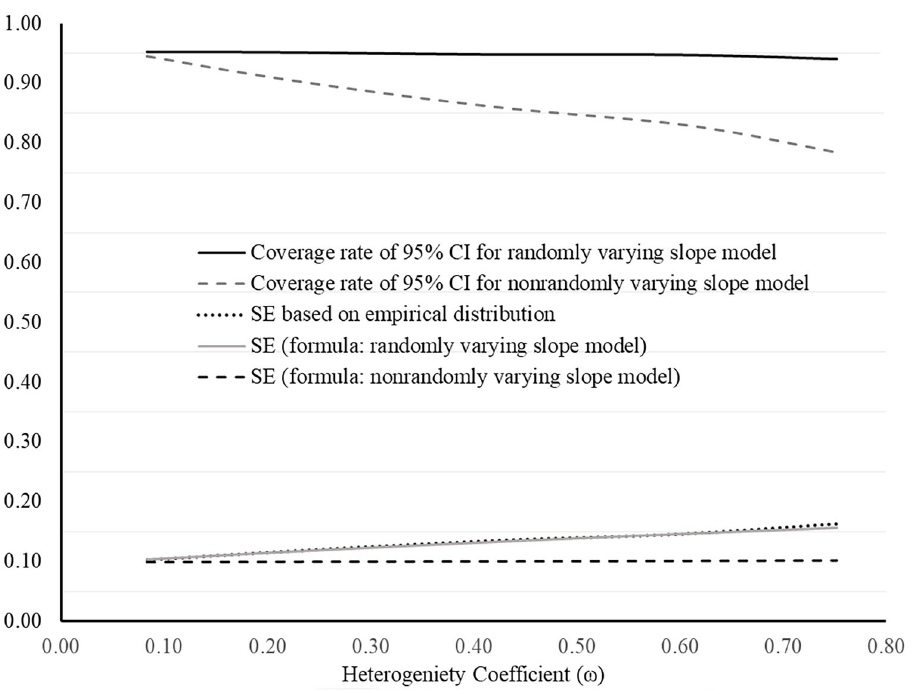
Standard Error (SE) and Coverage Rate of 95% CI vs. Heterogeneity